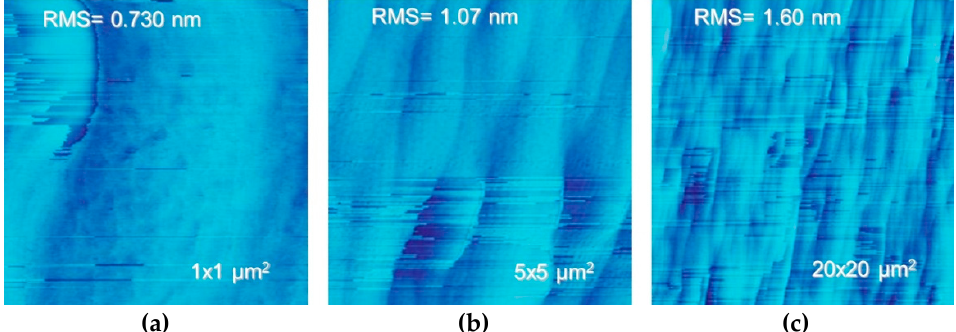
Figure 7. AFM images after epitaxial growth of the PIN device layers (a,b,c). The horizontal stripes are artifacts. are